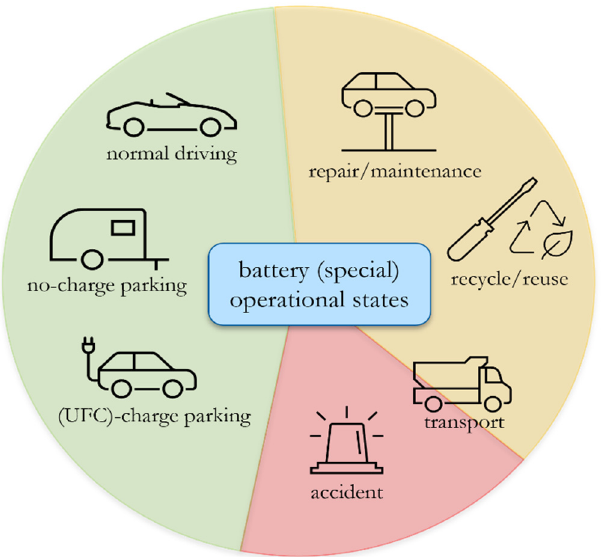
Figure 1. (Special) operational states and safety considerations for interactors (colors code the level of hazard for an interactor; green: low risk, orange: medium risk/raised awareness, red: highest risk).